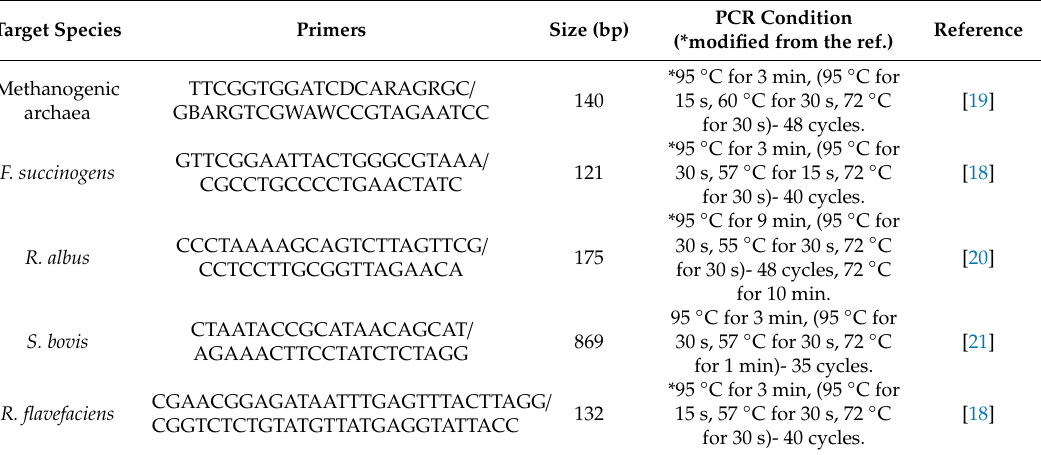
Table 1. List of Primers and PCR Conditions for Rumen Microbial